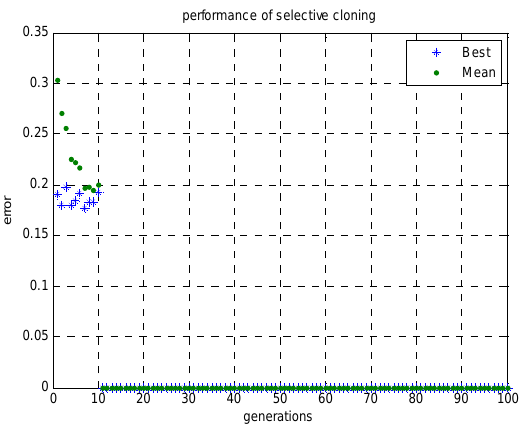
Fig 10 (a) Performance of GA for Balance Scale data set Fig 10 (b) Performance of Selectively Cloned GA for Balance Scale data